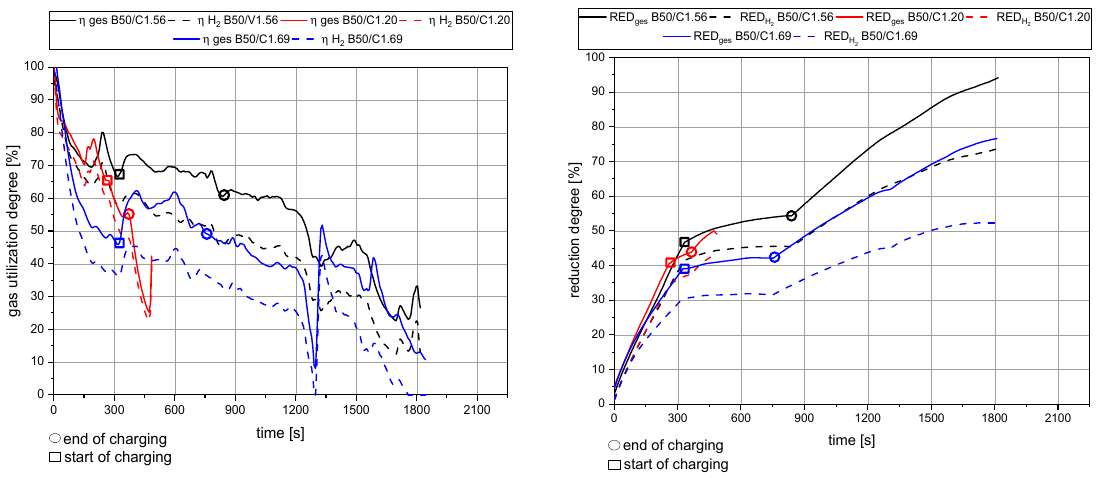
Figure 15. Gas utilization and reduction degree at 50 g batch and 50 g charged mass at 40 rounds per minute of the dosing unit.